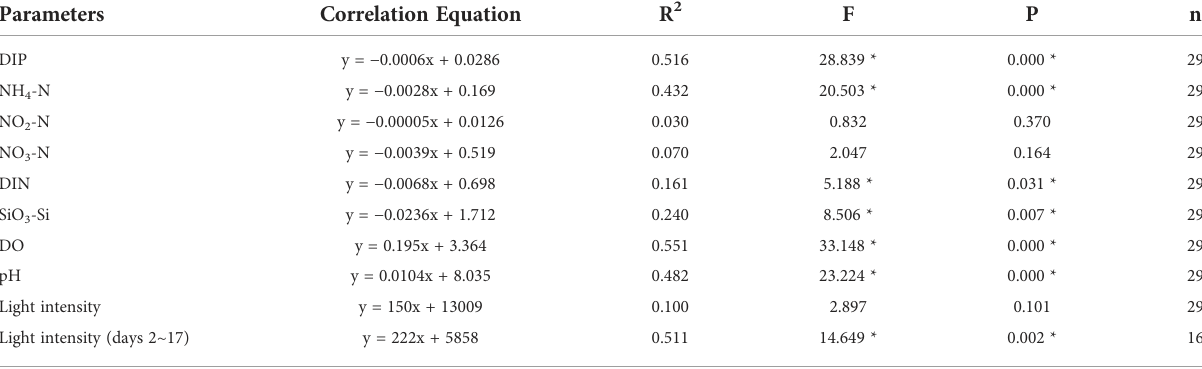
TABLE 3 Correlation analysis between the main environmental parameters and Chl-a.